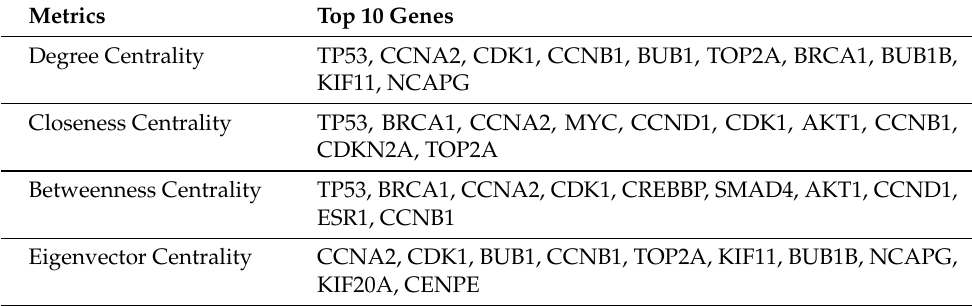
Table 1. Top 10 genes in four metrics of node